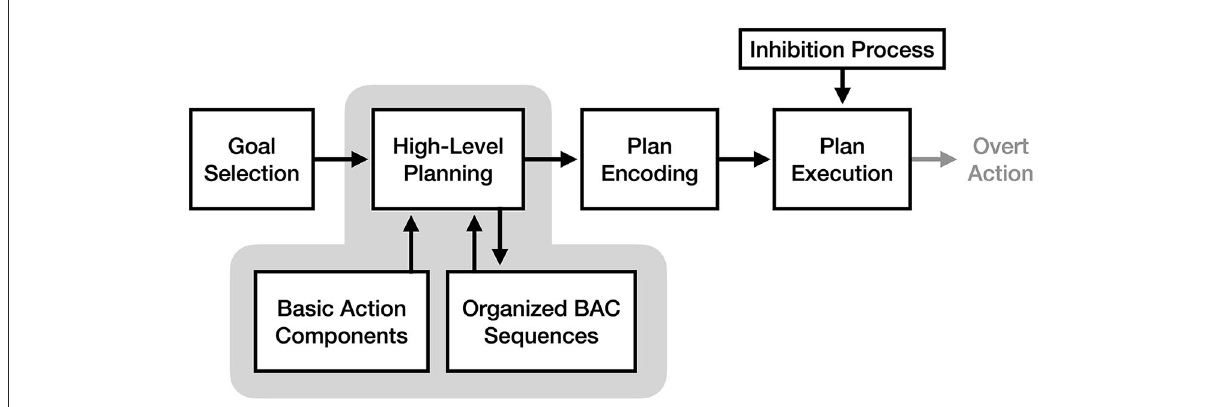
FIGURE5 The process of motor imagery as proposed by the perceptual-cognitive model. The stages of motor execution thought to be responsible for the experience of motor imagery are enclosed in